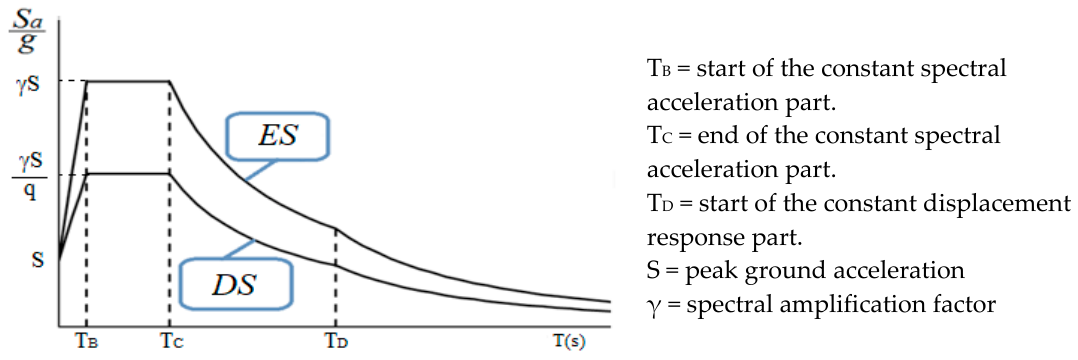
Figure 4. Elastic ( ES ) and design ( DS ) response spectra according to EC8 Figure 4. Elastic (ES) and design (DS) response spectra according to EC8 [16].